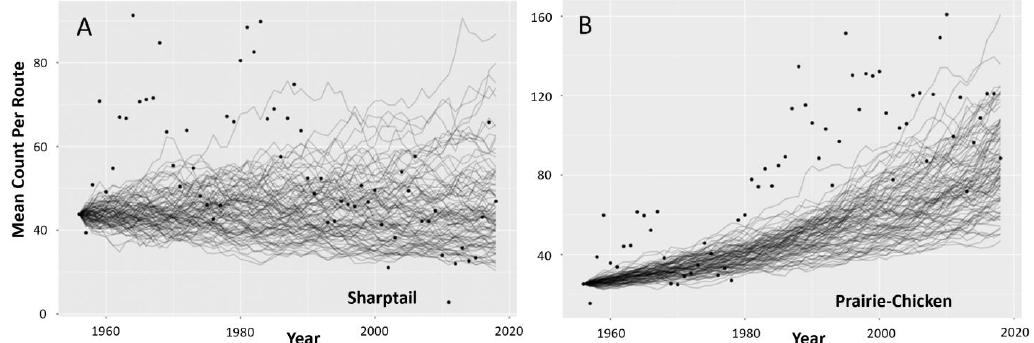
Figure 6. Predictions from 100 stochastic runs of ( A ) sharptail and ( B ) prairie-chicken exponential population growth models for the Sandhills of Nebraska, USA. Lines represent the average male count per route over 63 annual timesteps starting from the observed mean count in 1956. Points denote observed annual mean counts from 1956 to 2018.